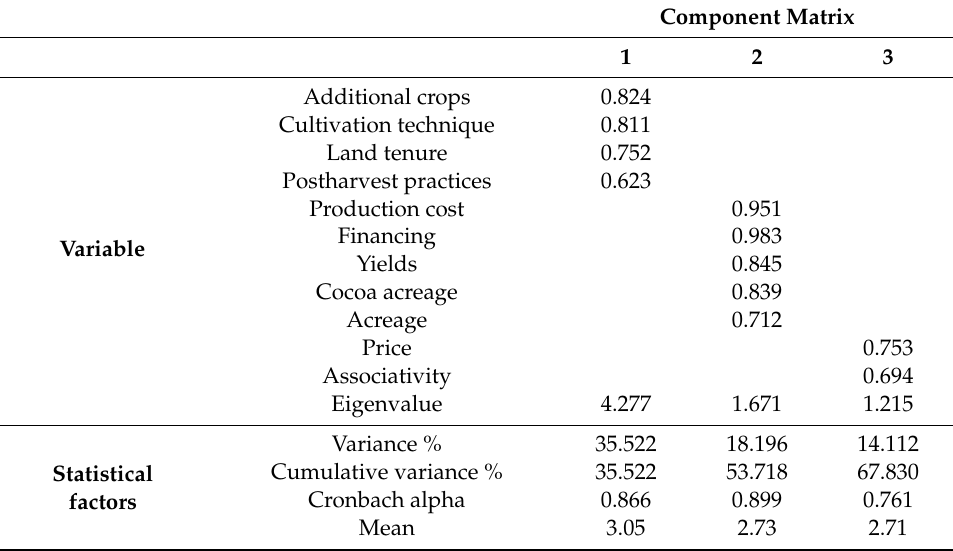
Table 7. Matrix of extracted components from PCA analysis of CCN-51 cocoa producers.